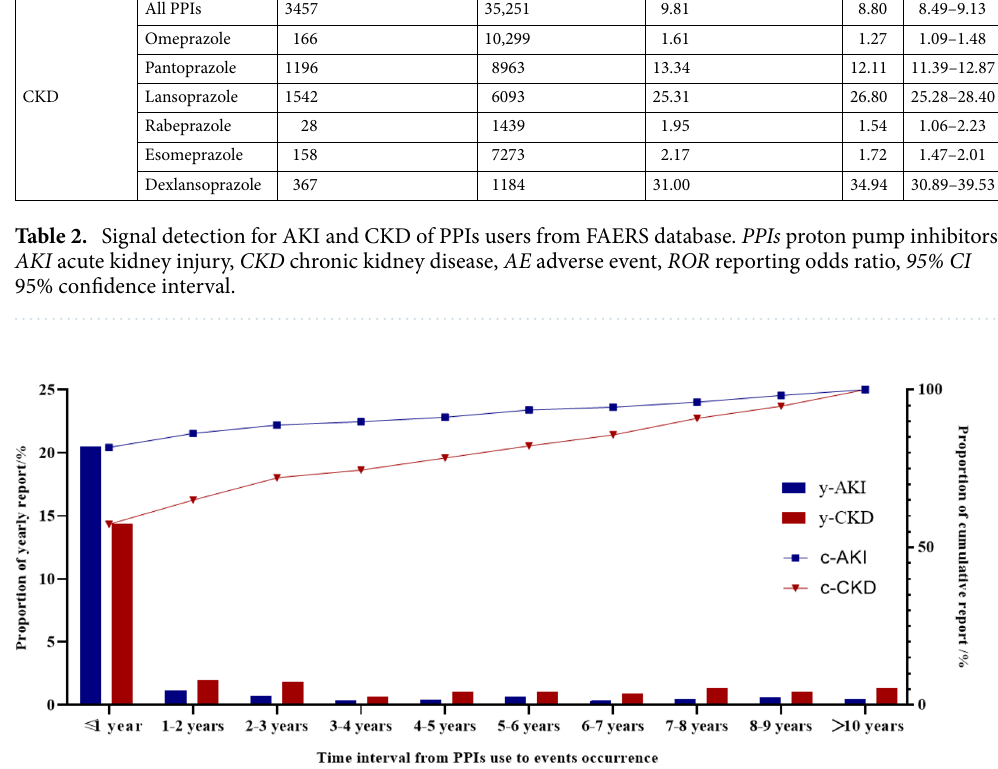
Figure 3. Time interval from PPIs use to AKI and CKD events occurrence from FAERS database. PPIs proton pump inhibitors, AKI acute kidney injury, CKD chronic kidney disease.